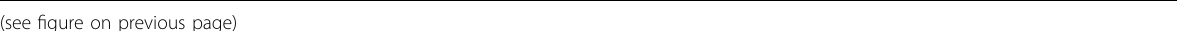
Fig. 2 Identi fi cation of tumor-speci fi c regulatory elements. a Heatmap of the Z-score normalized accessibilities of 22,682 scATAC-seq differential peaks for each cell type. b Pie plot of genomic annotations for scATAC-seq differential peaks. c Gene ontology term enrichment analysis for distal (intergenic region) and proximal (promoter and gene body) upregulated DARs in tumor cells. The Benjamini-Hochberg adjusted P values are shown on the right side of the plots. d Heatmap representation of chromVAR bias-corrected deviation scores for the differential TF motifs of each cell type. The top TF motifs of each cell type are indicated on both sides of the plot. e Heatmap of the log 2 (FC) values for tumor-speci fi c TFs identi fi ed by our fi ltering strategy. The right bar plot shows the Bonferroni-adjusted P values. f Kaplan – Meier overall survival curves of TCGA-KIRC patients grouped by the average expression of tumor-speci fi c TFs (with the median value as the threshold). HR hazard